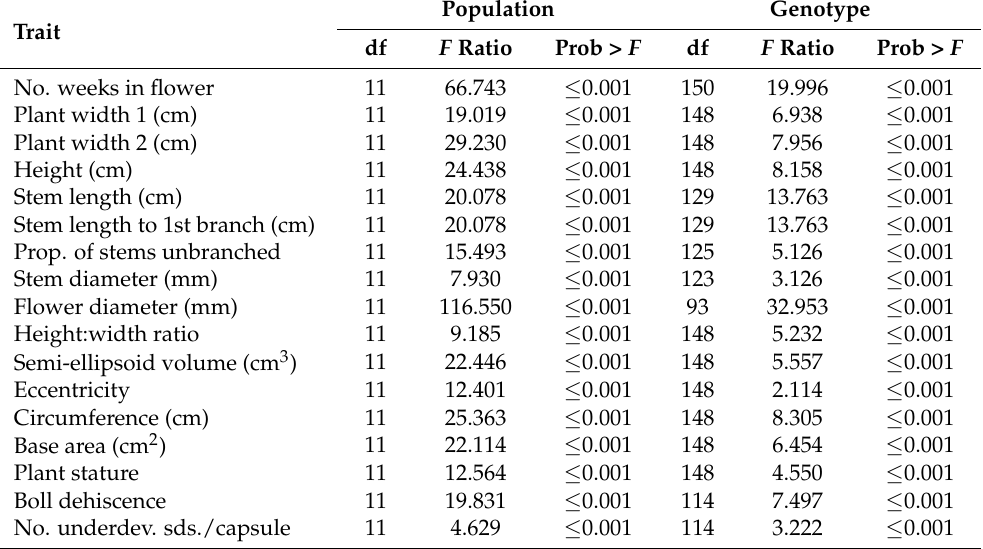
Table 2. ANOVA (df, F ratio, Prob > F) for the effects of population ( Linum species, selections) and genotype on the no. of weeks in flower, plant width 1 (cm), plant width 2 (cm), height (cm), stem length (cm), stem length to 1st branch (cm), proportion of stems unbranched, stem diameter (mm), flower diameter (mm), plant width (cm), height:width ratio, semi-ellipsoid volume (cm 3 ), eccentricity, circumference (cm), base area (cm 2 ), plant stature, boll dehiscence, and number of underdeveloped